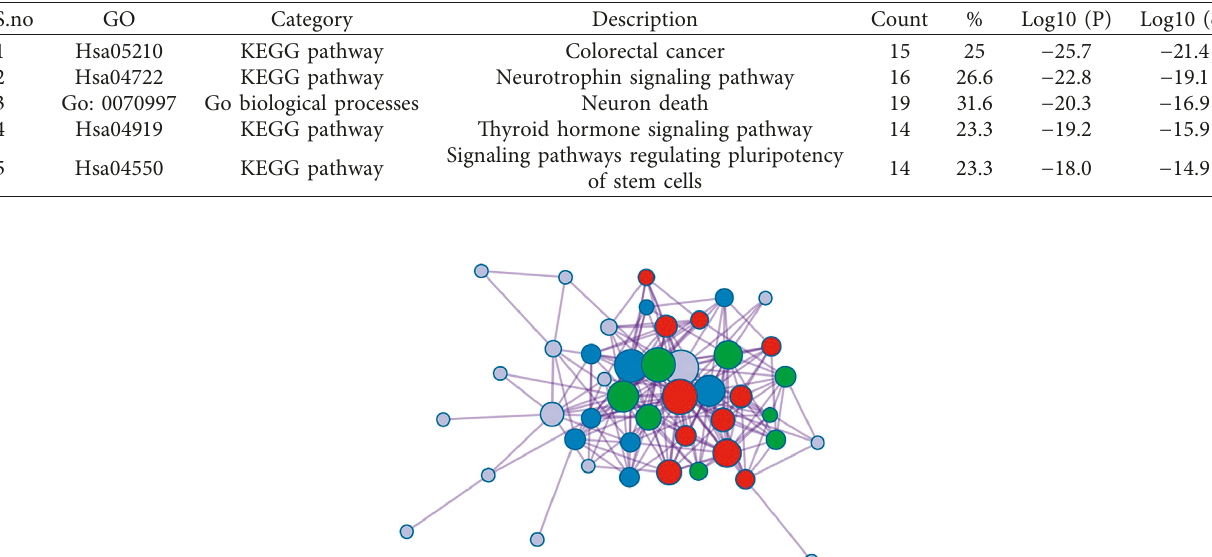
Figure 5: Heat map of enriched terms across input gene lists, colored by p values. Table 2: Pathway and process enrichment analysis.